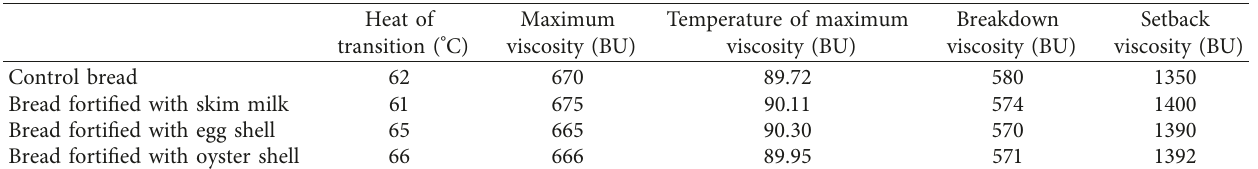
Table 3: Visco-Amylo-Graph parameters of the dough behaviour of the control bread and breads fortified with skim milk and egg shell and oyster shell powders.